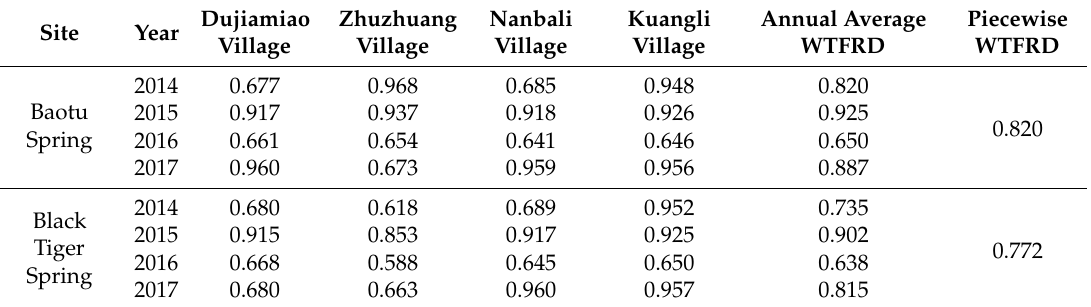
Table 7. WTFRD between Western Jinan and Jinan spring groups from August to November each year.